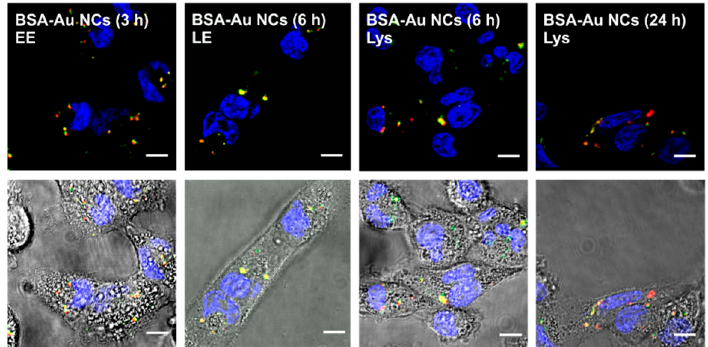
Figure 6. Intracellular distribution of photoluminescent BSA-Au NCs in early endosomes (EE), late endosomes (LE) and lysosomes (Lys). Yellow colour represents co-localisation of green fluorescent protein (GFP) labeled endosomal compartments and accumulated BSA-Au NCs. Scale bar is 10 μ m.